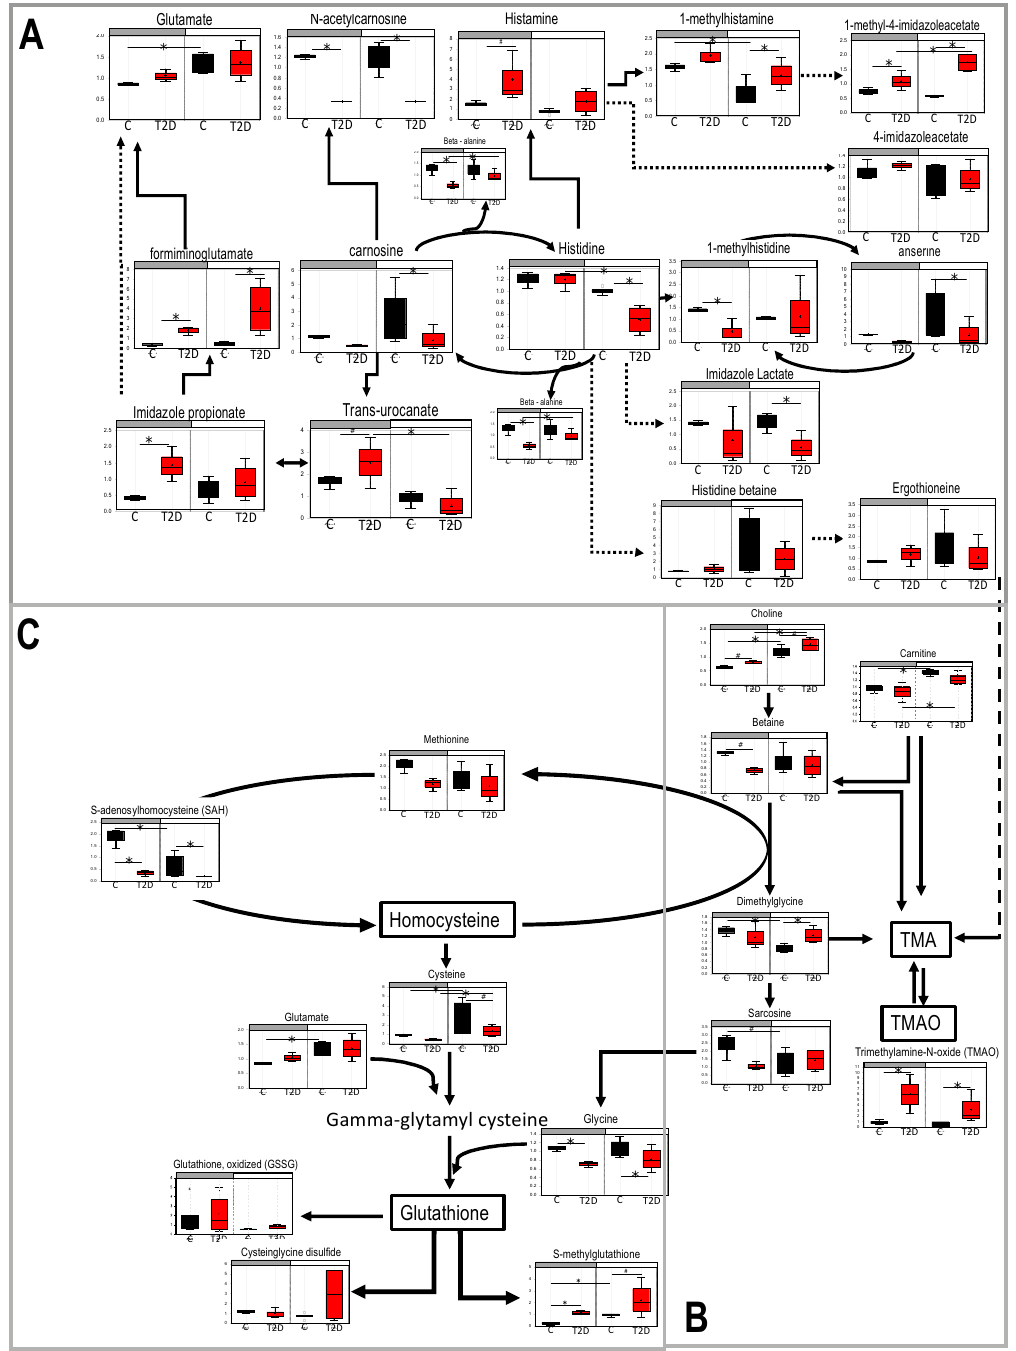
FIgure 4. Methionine and betaine metabolism . -metabolites in T2D loose cyrciadn regulation Figure 4 . Pathways of metabolites that showed up in the cluster that lost diurnal patterns in type 2 diabetes (T2D). Blood samples were collected at day time (ZT5) and at night time (ZT17) from 10-month-old db/db (diabetes, red) and aged-matched db/m (control, black) mice. Untargeted global metabolomics analysis was performed with the Metabolon Platform (Metabolon Inc). ( A ) Histidine metabolism pathway. ( B ) Betaine metabolism pathway. ( C ) Methionine/cysteine pathway. n = 3 per time point per group. Two-way ANOVA. (*) indicates statistical difference p < 0.05, and (#) p < 0.01 in post-hoc comparisons. y-axis shows the volume and median = 1 normalized values of area under the curve values form each metabolite. Bars above each chart (grey vs. white) indicate night vs. day.